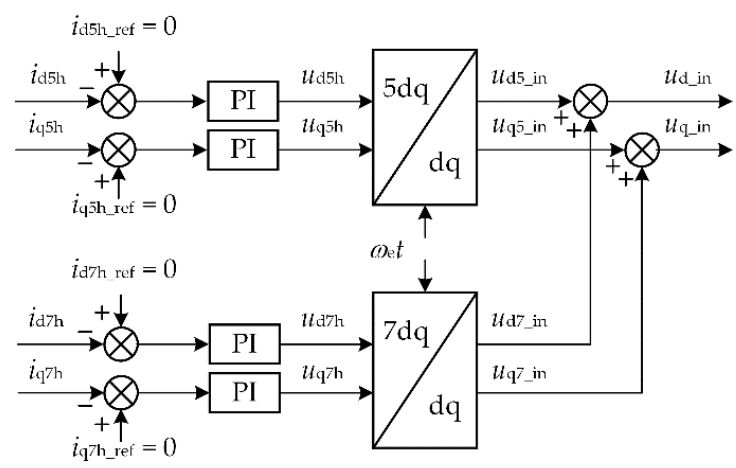
Figure 3. The block diagram of traditional current harmonic controller based on PI. Where, the transformation matrices from the 5th and 7th synchronous rotating frames to the fundamental synchronous rotating frame are obtained by the inverse operation of Equations (7) and (9). The transformation matrices can be expressed as: